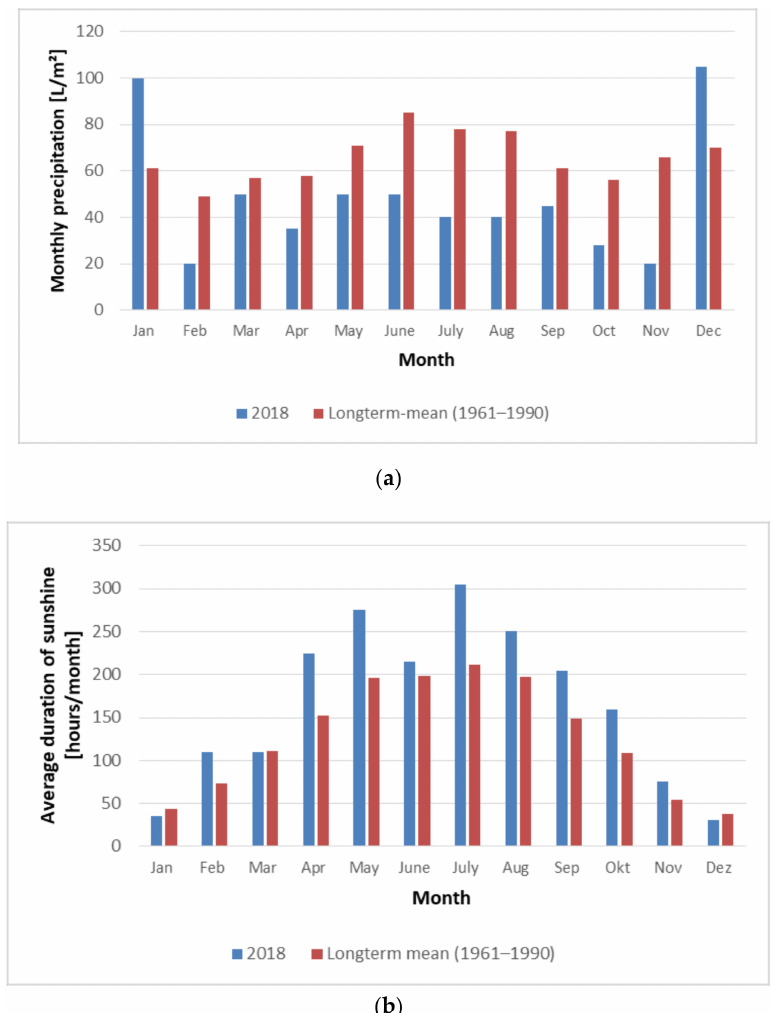
Figure 1. Conditions in Germany in 2018: ( a ) average monthly precipitation compared with long-term means (in L / m 2 ) [2] (source: [2], translated); ( b ) average monthly sunshine in 2018 in Germany compared with long-term means (in hours / month) [4] (source: [4],